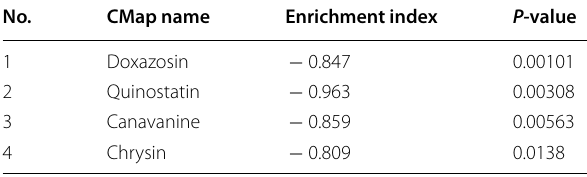
CMap connectivity map